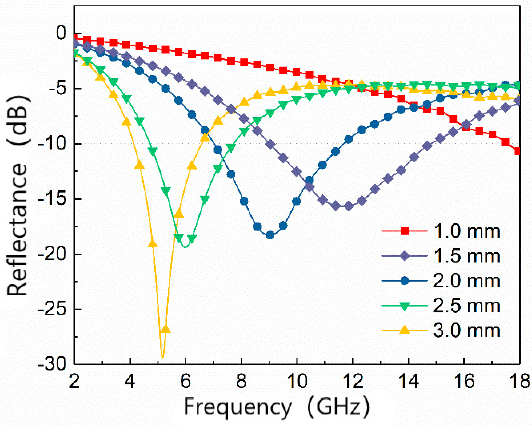
Figure 5. The RL of S1.5 at various thicknesses.